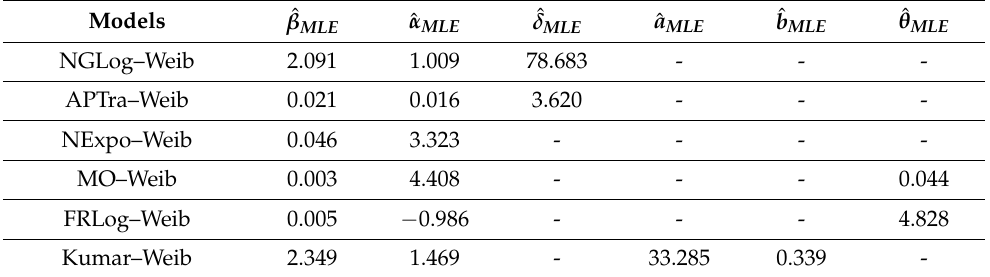
Table 15. The ˆ β MLE , ˆ α MLE , ˆ δ MLE , ˆ a MLE , ˆ b MLE and ˆ θ MLE values for the patients receiving analgesics’ data (dataset